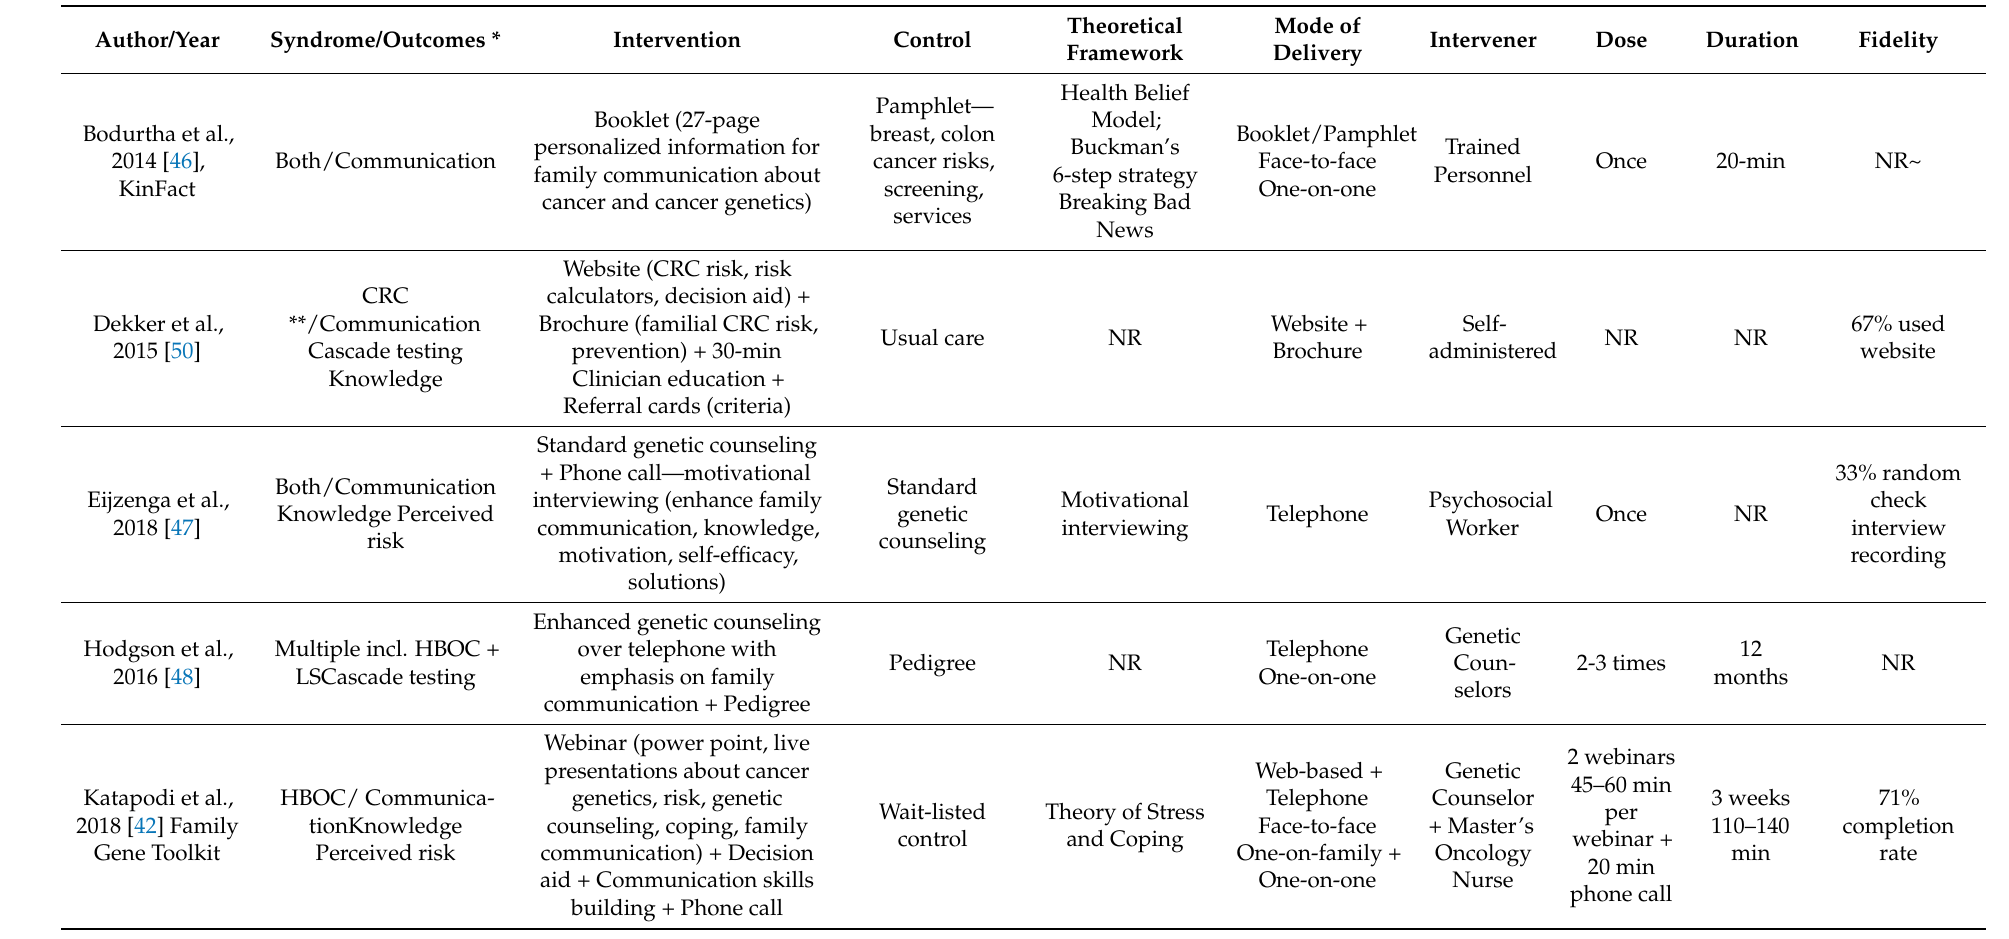
Table 1. Characteristics of study